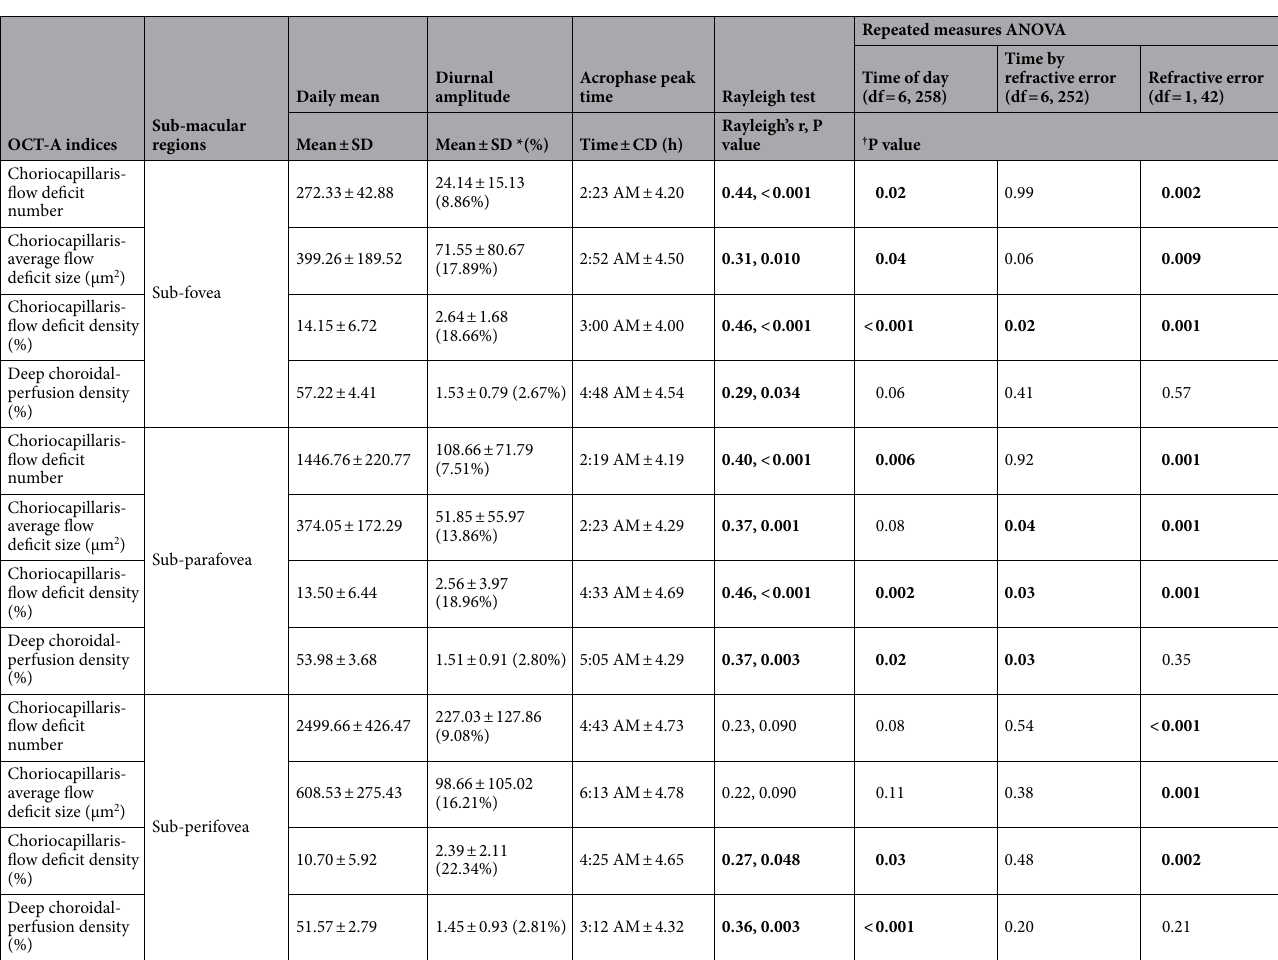
and 6 AM in the three regions (Table 1). Figure 2a plots the changes in the choriocapillaris flow deficit indices across 24 h to demonstrate the general diurnal pattern for all participants. Diurnal variation in deep choroidal perfusion density for all participants. The deep choroi- dal perfusion density exhibited significant diurnal variation in the sub-parafoveal and sub-perifoveal regions (P < 0.001 for both) with diurnal amplitudes of 1.51 ± 0.91 % and 1.45 ± 0.93 % and acrophases at 5:05 AM and 3:12 AM (Table 1). The sub-foveal deep choroidal perfusion density did not exhibit significant diurnal variations. Bonferroni adjusted pairwise comparisons revealed significantly higher perfusion density (P = 0.049) at 5 AM (54.39 ± 3.88 %) than 5 PM (53.70 ± 3.72 %) in the sub-parafoveal region. The perifoveal perfusion density meas- urements at 5 AM (52.29 ± 3.04 %) were also significantly higher than measurements at 9 AM (51.45 ± 2.64 %; significant diurnal variations. Figure 2b illustrates an example pattern of the change in deep choroid perfusion density across 24 h for all participants in the perifoveal region. Time by refractive group interaction for choriocapillaris OCT‑A indices. Myopes differed from non-myopes in the pattern of their diurnal variation in the sub-foveal (P = 0.02) and sub-parafoveal choriocapil- laris flow deficit density (P = 0.03) (Fig. 3a,b). Further analysis showed that the acrophase of the choriocapillaris flow deficit density in the sub-foveal and sub-parafoveal regions occurred significantly earlier (P = 0.04) in myopes